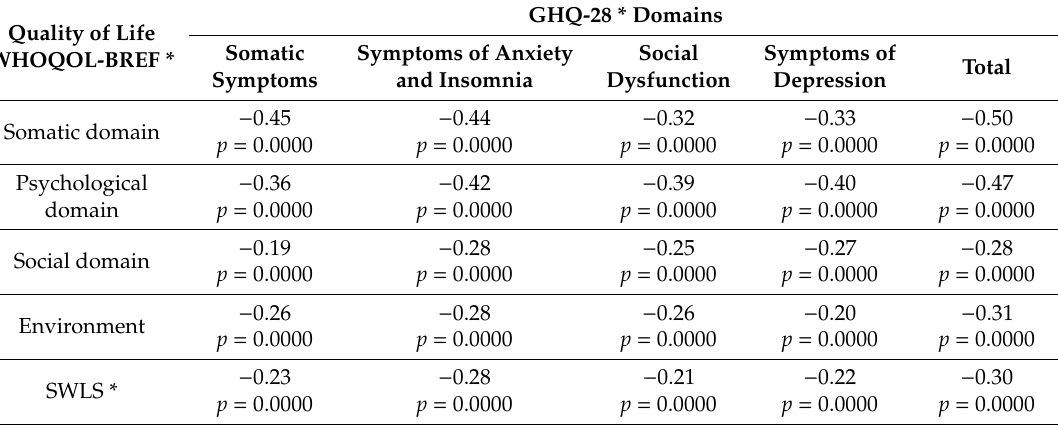
Table 4. Spearman’s rank correlation coe ffi cients between quality of life and satisfaction with life and respondents’ mental health status. Quality of